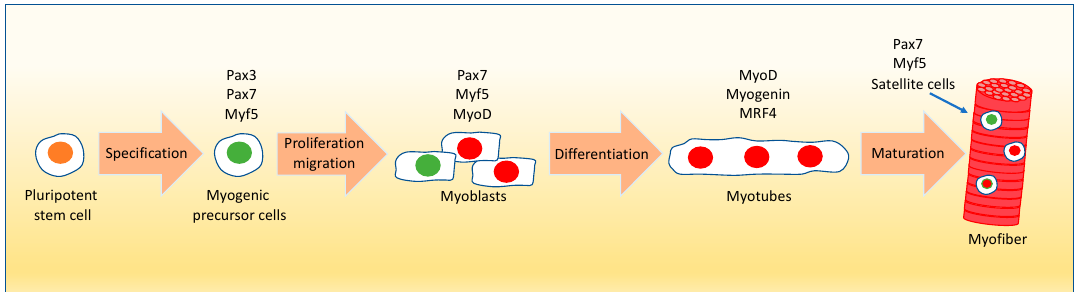
Figure 1. Myogenic lineage in myofiber formation. The myogenic precursor cells (Pax3 / Pax7 / Myf5 positive) are derived from pluripotent stem cells of the dermomyotome compartment of the somites during embryogenesis and undergo multiple waves of division followed by migration for the formation of myofibers in di ff erent parts of the body. The primary myofibers arise mostly from Pax3 positive myogenicprogenitorcells, whereasthesecondarymyofibersareformedfromthePax7positivemyogenic progenitors using the primary myofibers as sca ff old. Subsequent to activation and proliferation, the myogenic precursor cells transform into myoblasts expressing Pax7, Myf5, and MyoD. Myf5 acts alongside the expression of paired box genes, which is followed by the expression of MyoD, a downstream e ff ector of myogenesis. During di ff erentiation, the committed myoblasts, also known as myocytes expressing MyoD, exit the cell cycle, and fuse to form the multinucleated myotubes upon the induction of Myogenin and MRF4 genes. During both myoblast proliferation and di ff erentiation some cells maintain high levels of Pax7 expression and self-renew to maintain tissue homeostasis (satellite cells pool). The mature myotubes turn into myofibers upon the expression of various structural proteins such as myosin light and heavy chains and myocyte enhancer factor 2c. Myonuclei—red; stem cell nuclei—green. The blue arrow points to a satellite cell located on the myofiber. Pax3 / 7: paired box 3 /